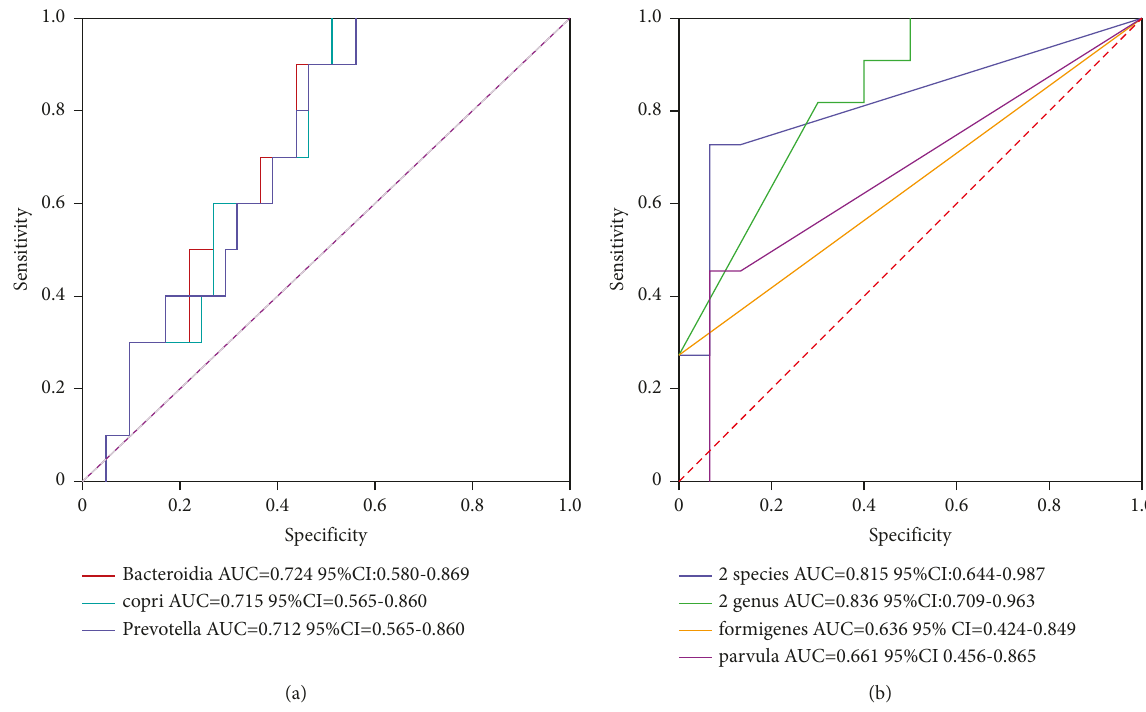
Figure 4: ROC analysis for the predictive value. (a) Relative abundance of 3 hypertension-associated genera that distinguish hypertension from controls is plotted on a logarithmic scale, and the values of zero are assigned and (b) relative abundance of 2 H-CKD-associated genus and 2 species that distinguish H-CKD from controls are plotted on a logarithmic scale, and the values of zero are